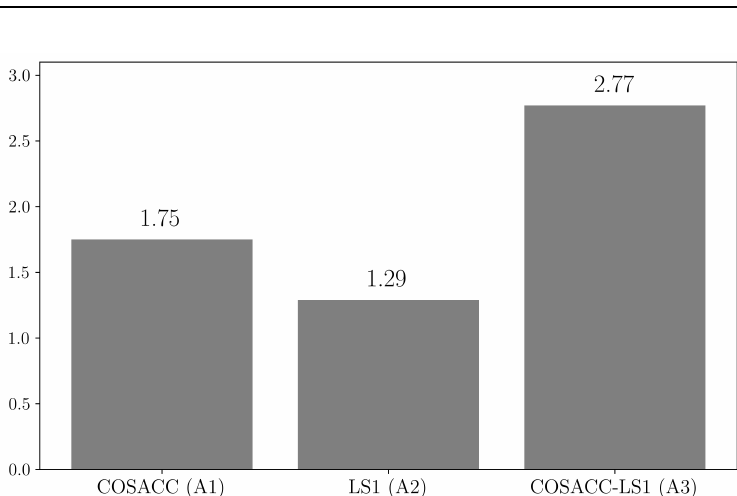
Figure 2. Average ranks of COSACC, LS1, and COSACC-LS1